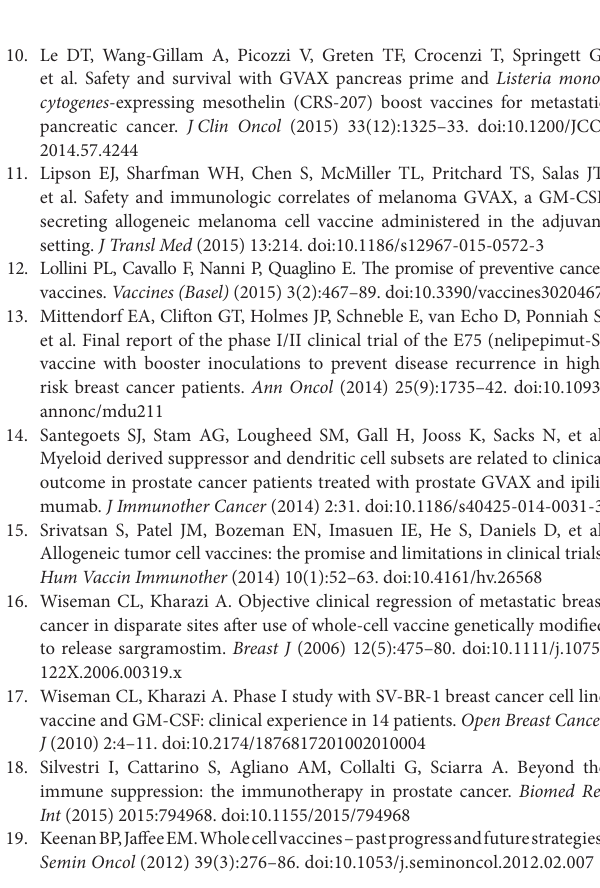
Figure S5: Levels of GM-CSF secreted by nonirradiated SV-BR-1-GM cells are shown. Figure S6: Overview of the in silico filtration strategy to identify candidate TAAs. Figure S7: Illustration of the low- and medium-stringency in silico filtration approach. Figure S8: Genes expressed in SV-BR-1-GM cells and located on chromosome 17q12 (“ERBB2 amplicon”). Figure S9: Hypothetical mechanism of action of SV-BR-1-GM as a therapeutic cancer vaccine (A). Factors expressed